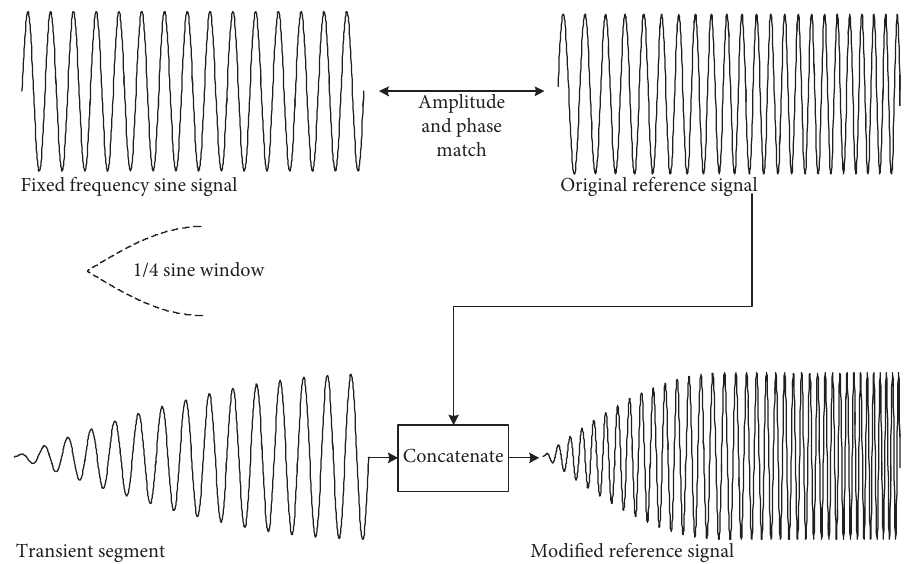
Figure 1: Modification of the original reference signal.